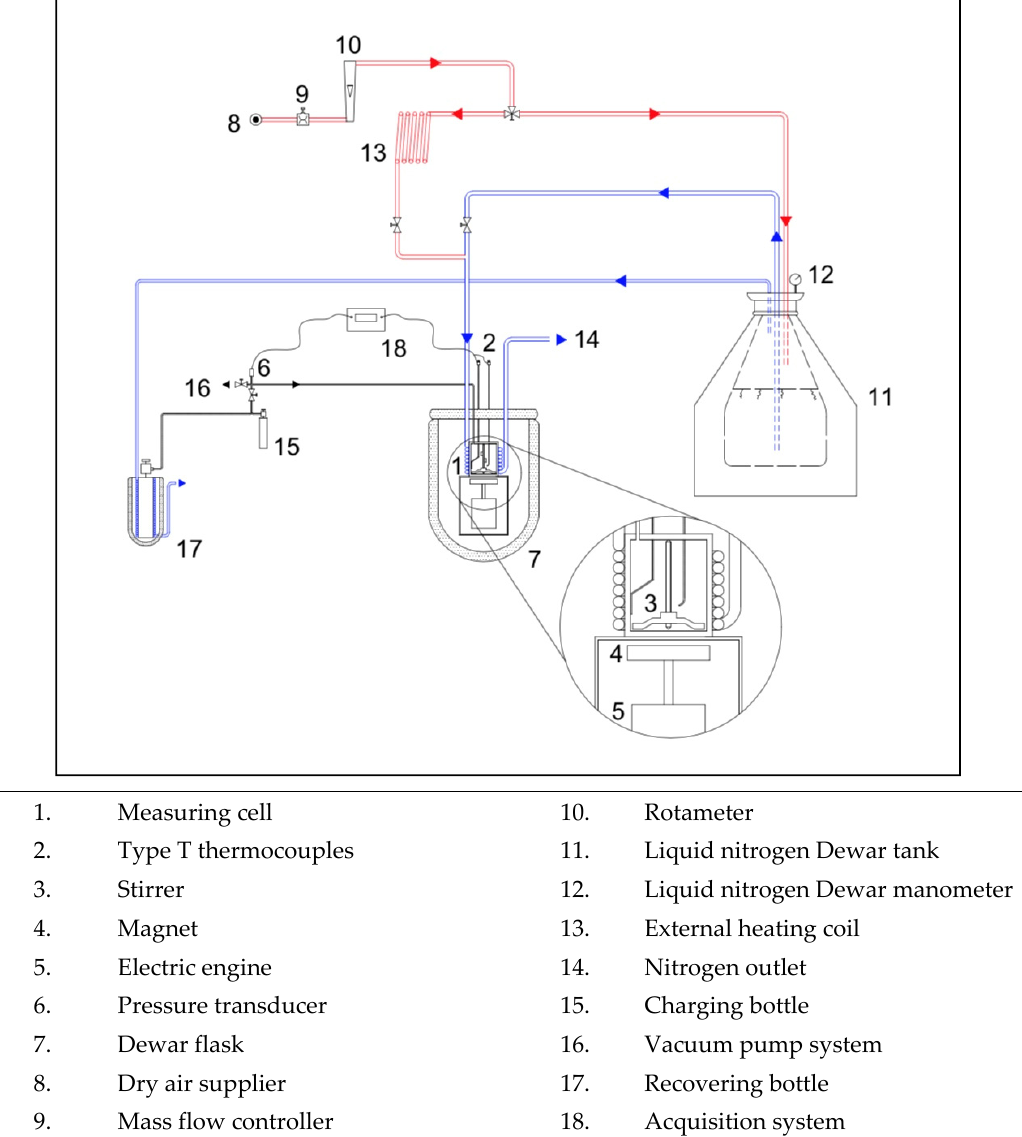
Figure 2. Schematic view of the Solid-Liquid Equilibrium (SLE) apparatus.